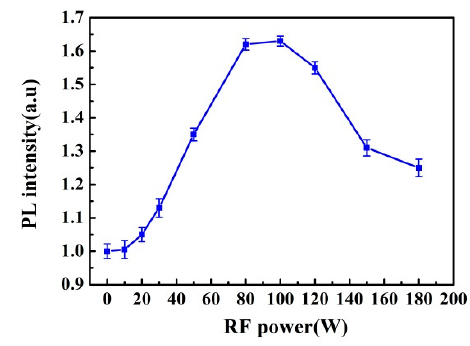
Figure 1. The influence of radio frequency (RF) power on photoluminescence (PL) intensity.